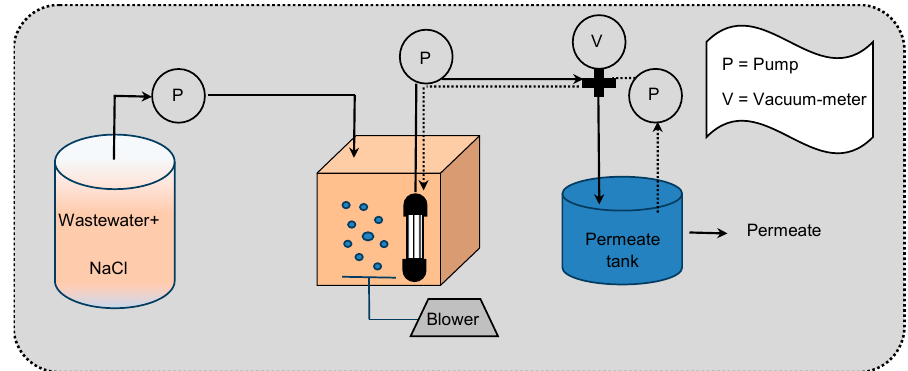
Figure 1. Pilot plant schematic layout.